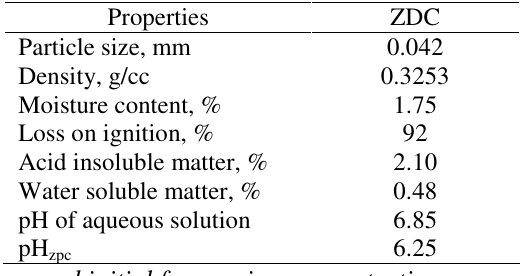
Table 1. Characteristics of the